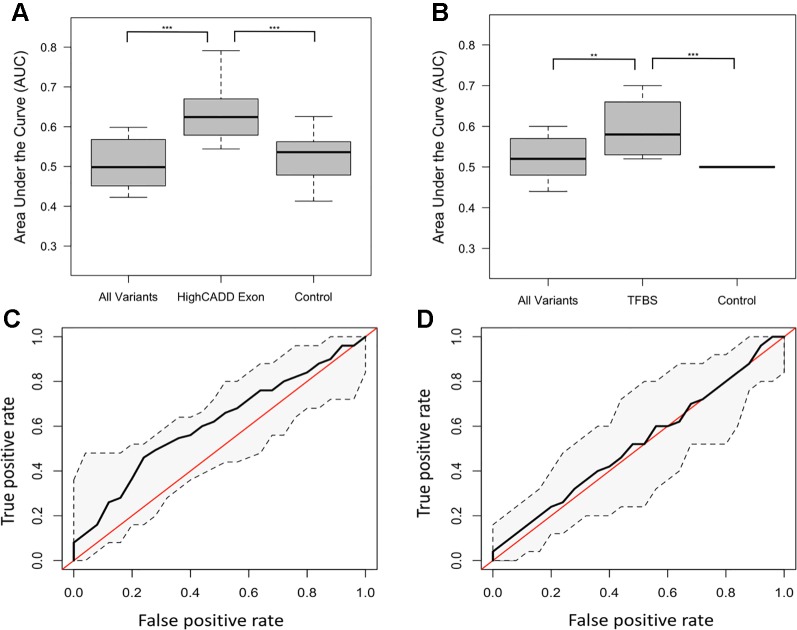
Different subsets of variants defined as top predictive models using random forest and support vector machine (SVM) learning methods. (A) Boxplots of the random forest model area under the curve (AUCs) for the all variant, high Combined Annotation-Dependent Depletion (CADD) exon and control subsets of the variant data. P-values between groups determined by performing a Kruskal-Wallis test. **** = p < 0.0001, *** = p < 0.001. (B) Boxplots of the SVM model AUCs for the all variant, transcription factor binding site (TFBS), and control subsets of the variant data. P-values between groups determined by performing a Kruskal-Wallis test. (C) Receiver-operating characteristic (ROC) curve of the mean high CADD exon random forest model with confidence intervals. The red line represents the null AUC (0.5). (D) ROC curve of the mean TFBS SVM model with confidence intervals. The red line represents the null AUC (0.5).